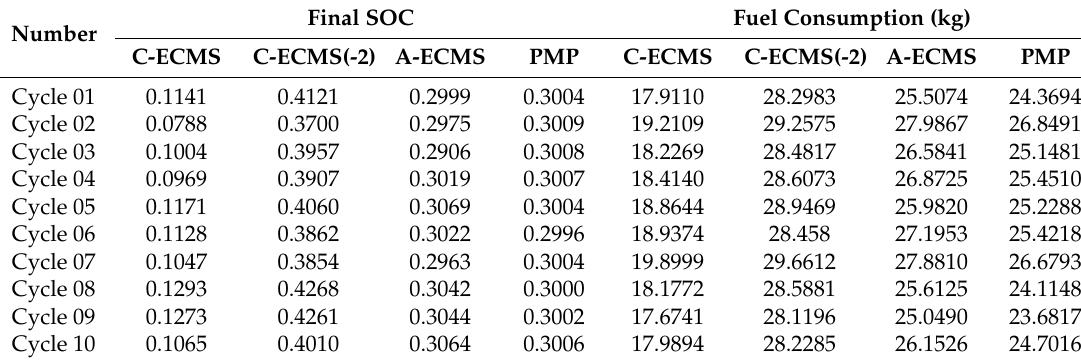
Table 6. Comparison statistics with initial SOC = 0.95.